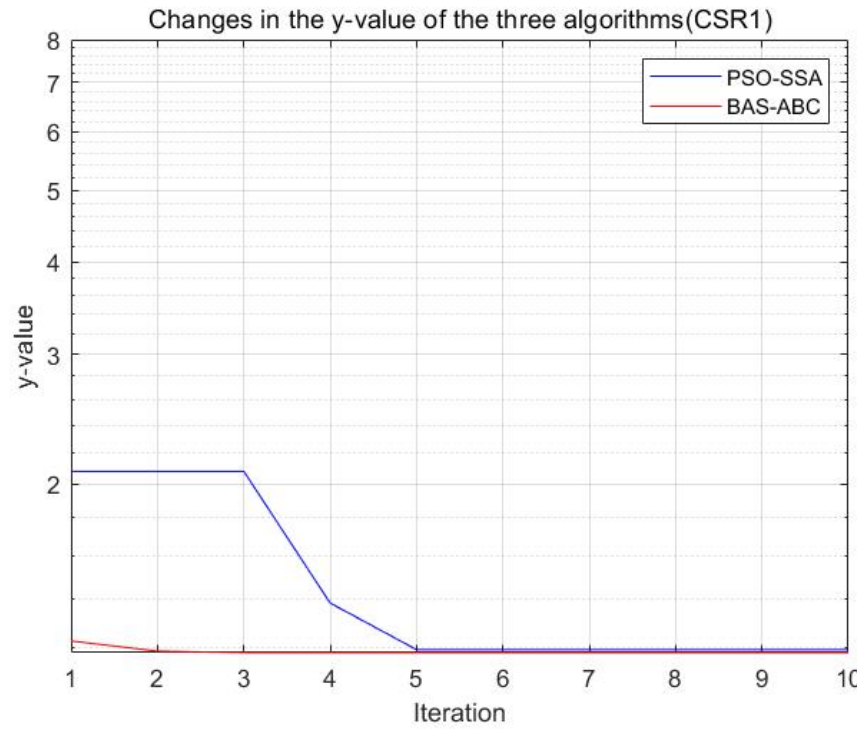
Figure 24. Changes in the y value of the two algorithms (SS3).